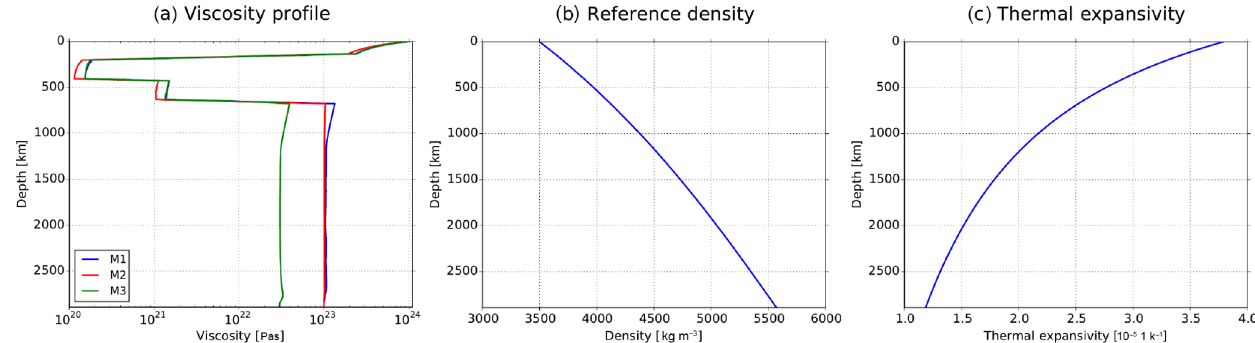
Dynamic topography is computed from normal stresses